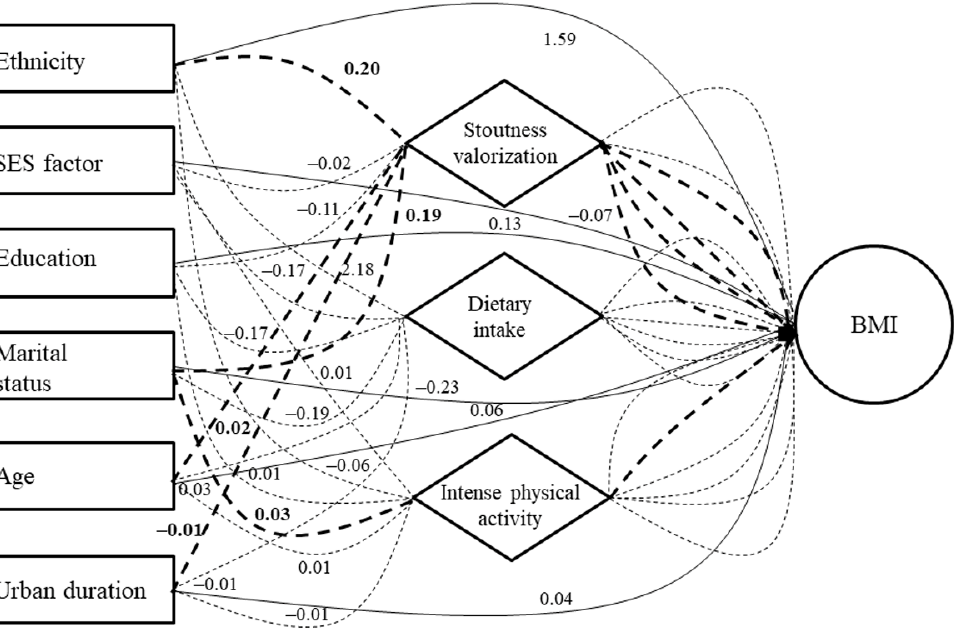
Figure 5. Results of structural equation modeling (SEM) showing associations between sociodemo- graphic/socioecological predictors and body mass index in women. Continuous lines are direct sociodemographic effects and dotted lines are indirect sociodemographic effects. Bold lines (con- tinuous and dotted) represent statistically significant paths. Simple lines (continuous and dotted) represent statistically non-significant paths.